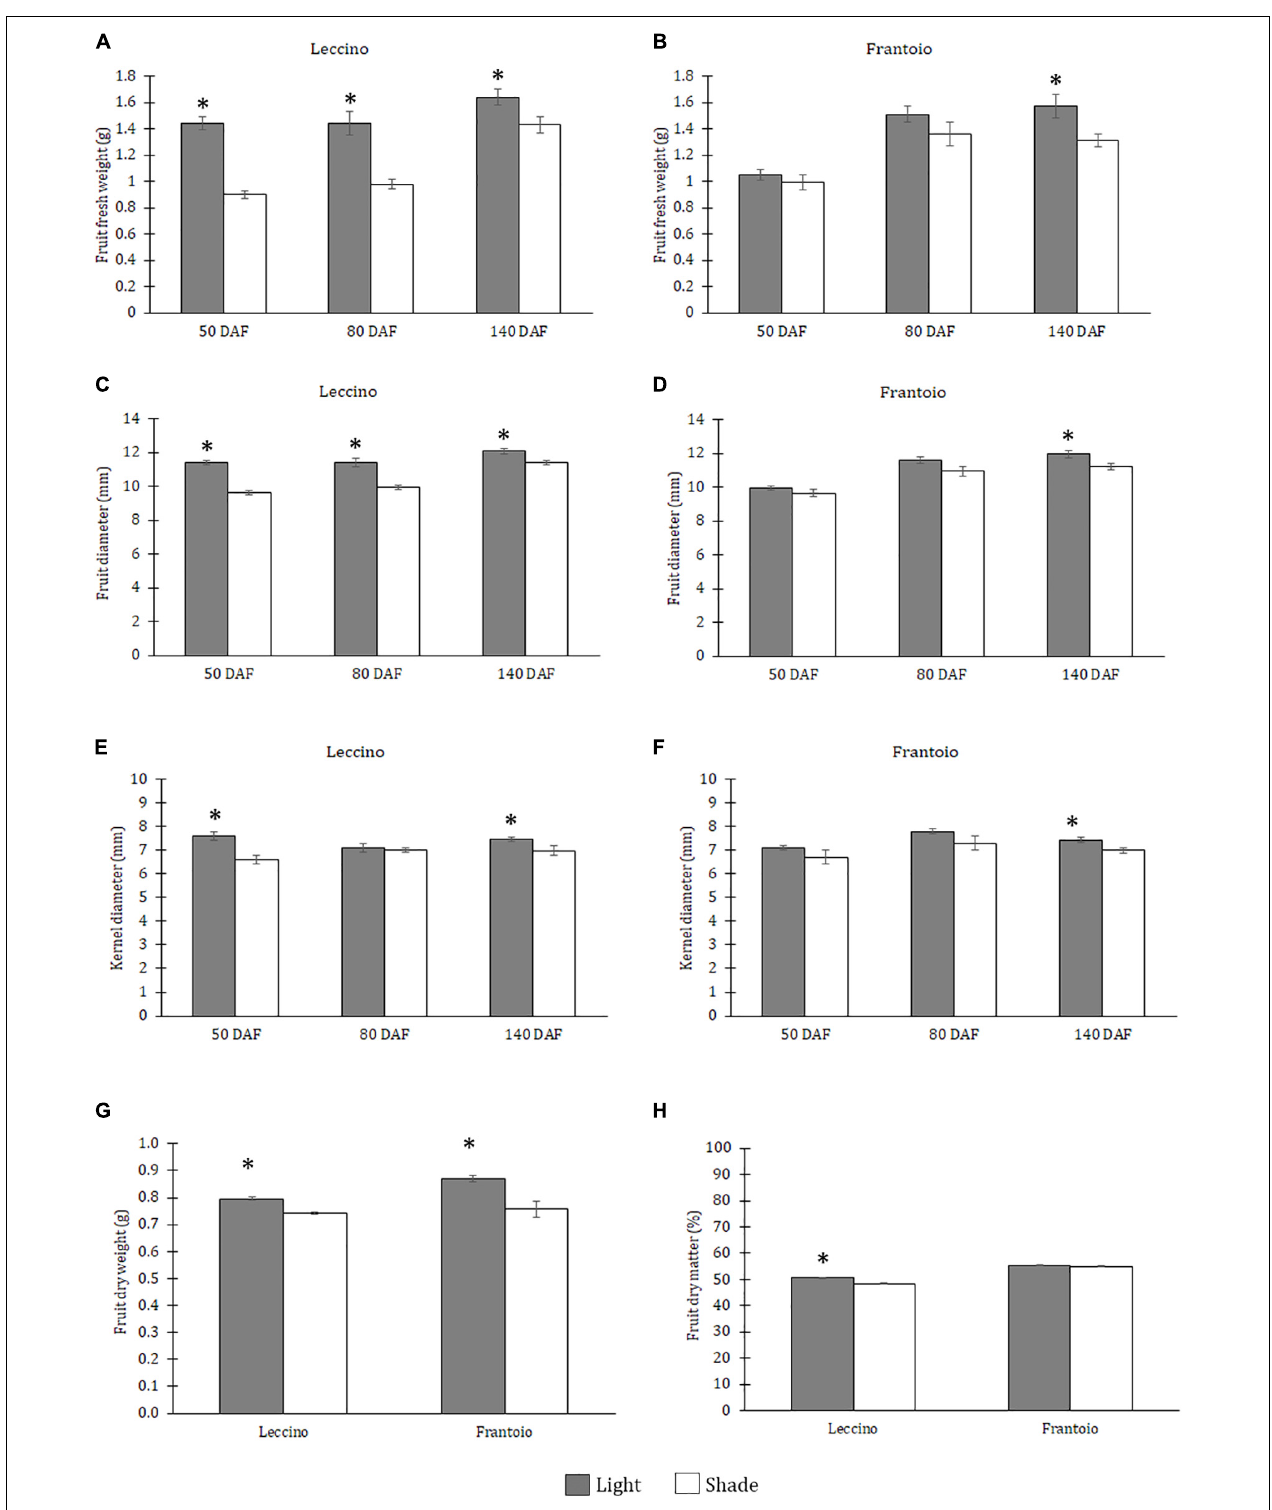
FIGURE 1 | Fruit fresh weight (A,B) , fruit diameter (C,D) and kernel diameter (E,F) in Leccino (A,C,E) and Frantoio (B,D,F) shade and light fruits at different developmental stages. Dry weight (G) and dry matter (H) in Leccino and Frantoio shade and light fruits at 140 DAF. Data are reported as means ± standard errors per cultivar (Leccino and Frantoio) and light environment (light and shade). The asterisks indicate significant differences ( t -test) between treatments after Analysis of Variance within each date of sampling ( P < 0.05).